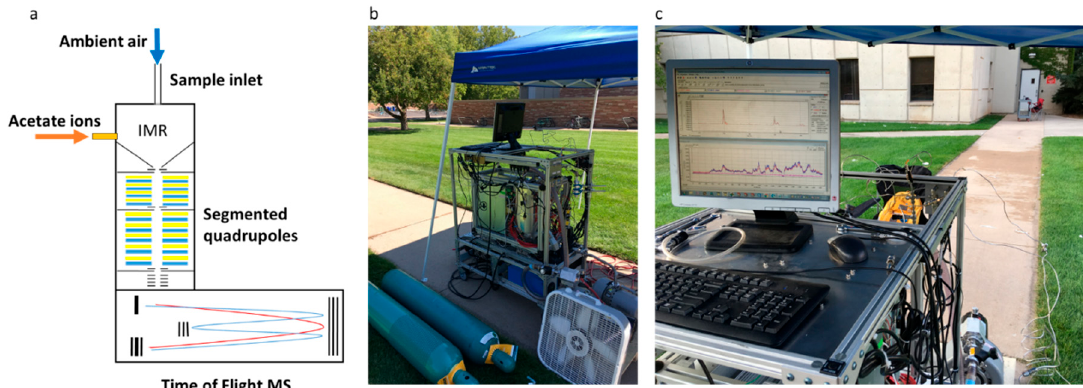
Figure 1. ( a ) A schematic of the time-of-flight chemical ionization mass spectrometer with acetate reagent ions (acetate-CIMS) demonstrating how ambient air is pulled in from a vertically-oriented inlet into an ion-molecule reaction chamber (IMR), where ambient air molecules are ionized through reaction with acetate ions. Air and ions are pulled through a series of segmented quadrupoles as the pressure is dropped, before orthogonal extraction into a time-of-flight detector; ( b , c ) The acetate-CIMS was located under a shaded tent. Pesticides were applied to the surrounding lawn.